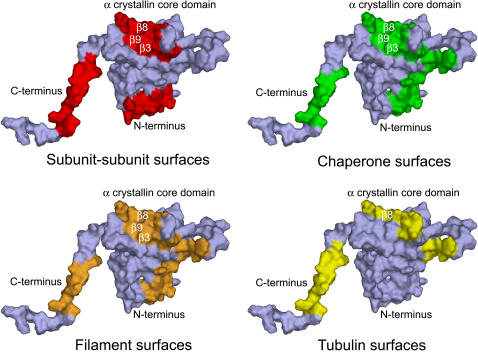
Surface locations of the interactive sequences in αB crystallin for subunit-subunit interactions, chaperone activity, and interactions with filaments and tubulin.Interactive sequences for subunit-subunit interactions, chaperone activity, and interactions with filaments and tubulin identified by in vitro assays, mutagenesis, and pin array analysis were mapped to the N-terminal, β3-β8-β9, and C- terminal interface regions of the human αB crystallin homology model. The ST sequence is in the N-terminal extension, the DR, LT, and FI sequences are in the β3 and β8 strands and the loop of the α crystallin core domain, and the ER sequence is in the C-terminal extension. Surfaces formed by the LT (β8) and ER (C-terminal extension containing the Ile-X-Ile motif) sequences mediated subunit-subunit interactions as well as interactions with unfolded substrate proteins, filaments, and tubulin.